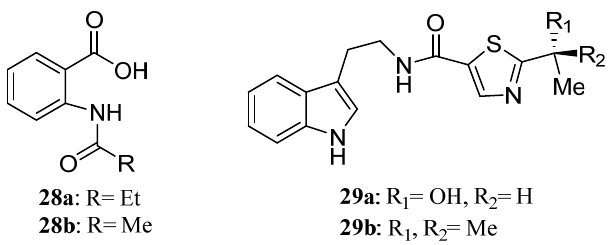
Molecules 2023 , 28 , x FOR PEER REVIEW 6 of 25 Table 1. Cancer cell line inhibition by hyrtioerectines D-F ( 26a - 26c ). Compound